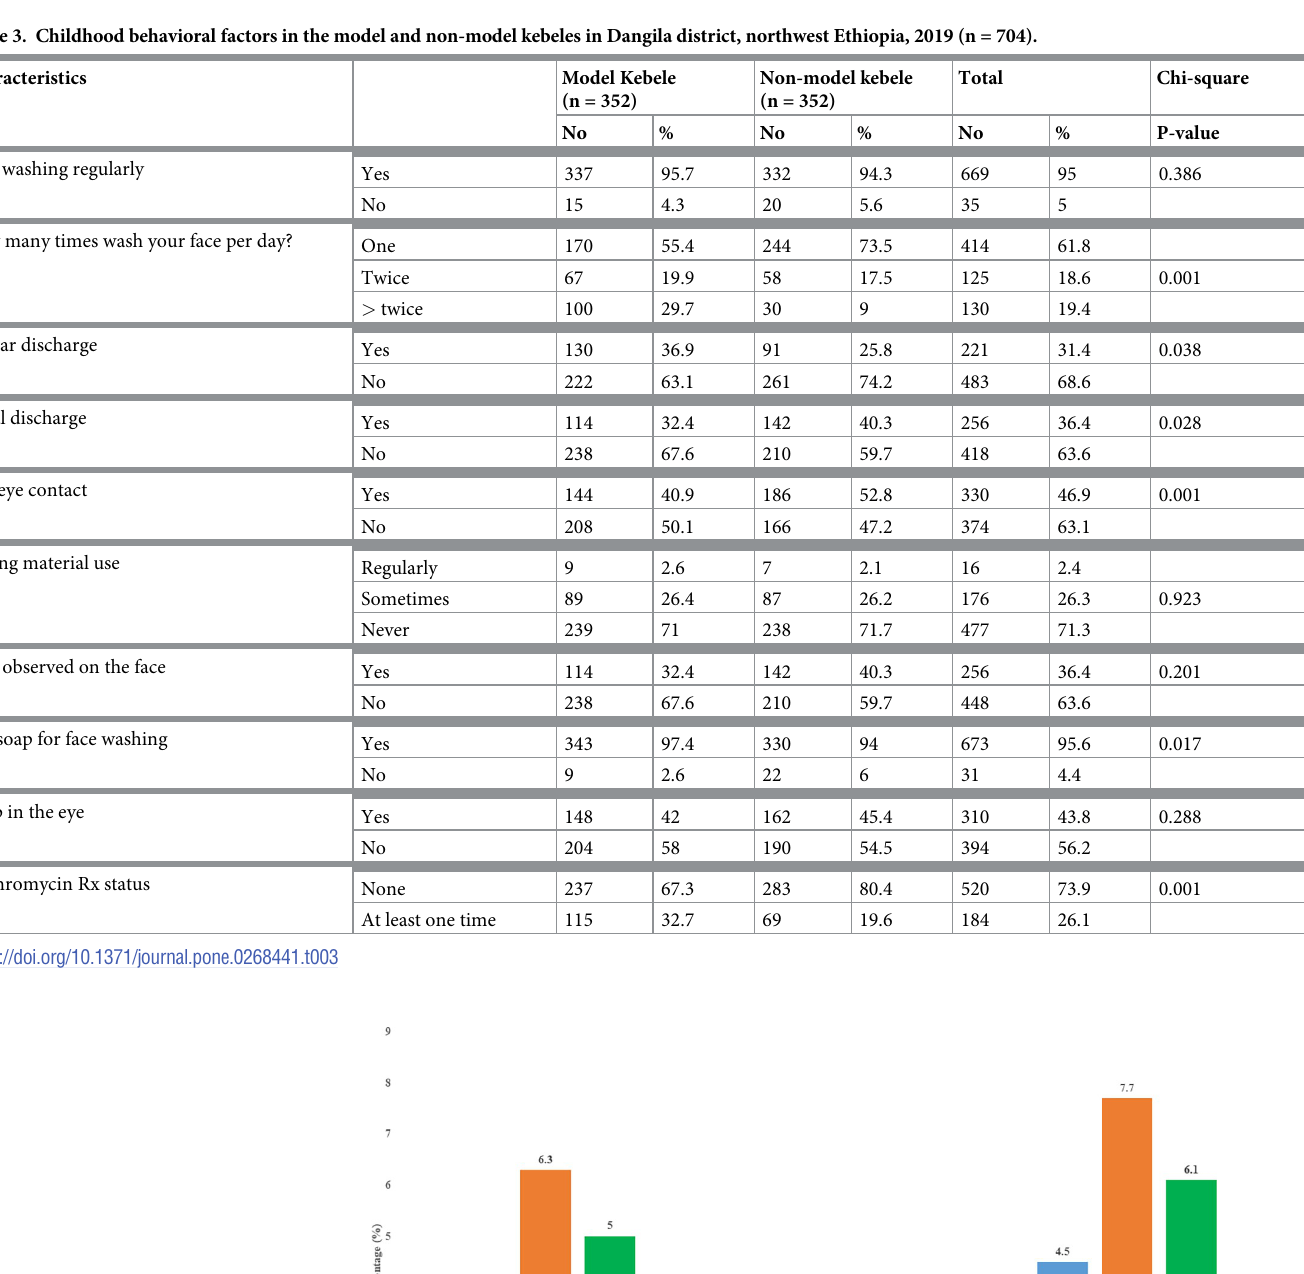
PLOS ONE | https://doi.org/10.1371/journal.pone.0268441 June 15,